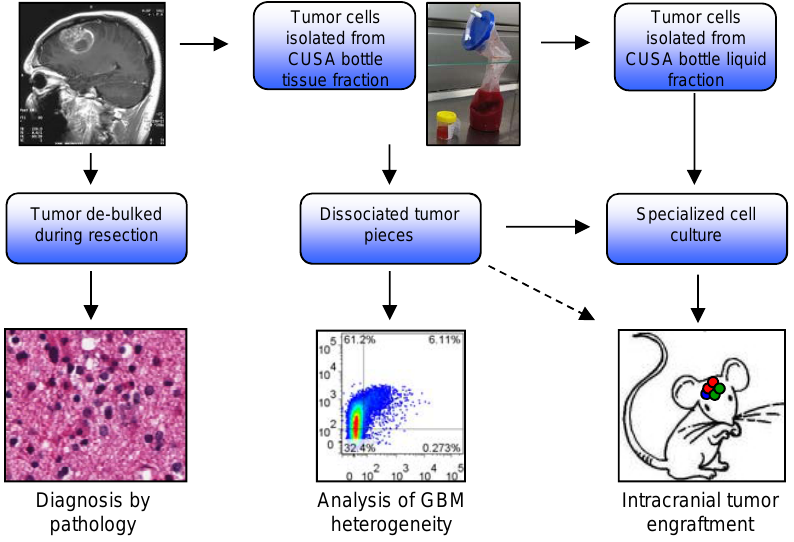
Figure 1. Diagram of experimental processes performed on surgical aspirate. Tumor margins can be resected using a cavitational ultrasonic surgical aspirator (CUSA) which deposits liquid (blood and irrigation fluid) and tissue waste into a sterile bottle for disposal. We isolated these cells and analyzed three aspects: culture generation, xenograft potential and analysis of marker expression using multiplex flow cytometry.